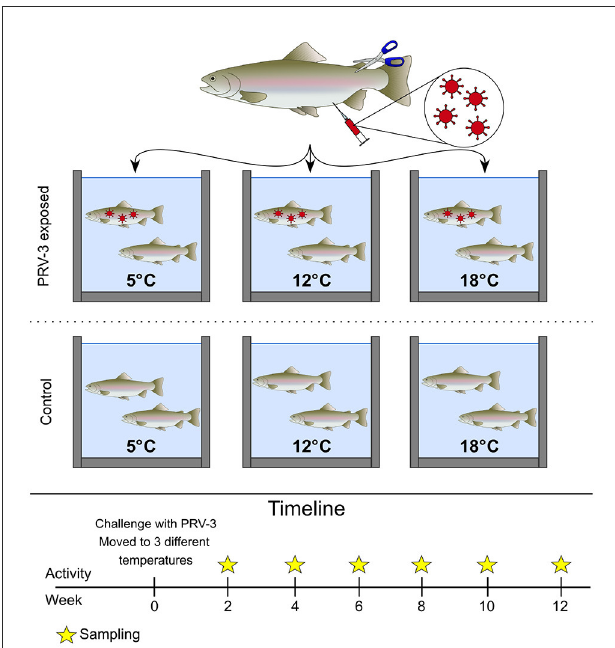
FIGURE1 Experimental trial setup. The trial was conducted as a cohabitation trial, with one control and one PRV-3 exposed tank per temperature. The fish were kept at 12 ◦ C until i.p., injection, and were then moved to the respective temperatures (5, 12, and 18 ◦ C). Samples were collected every 2nd week post challenge according to the sampling